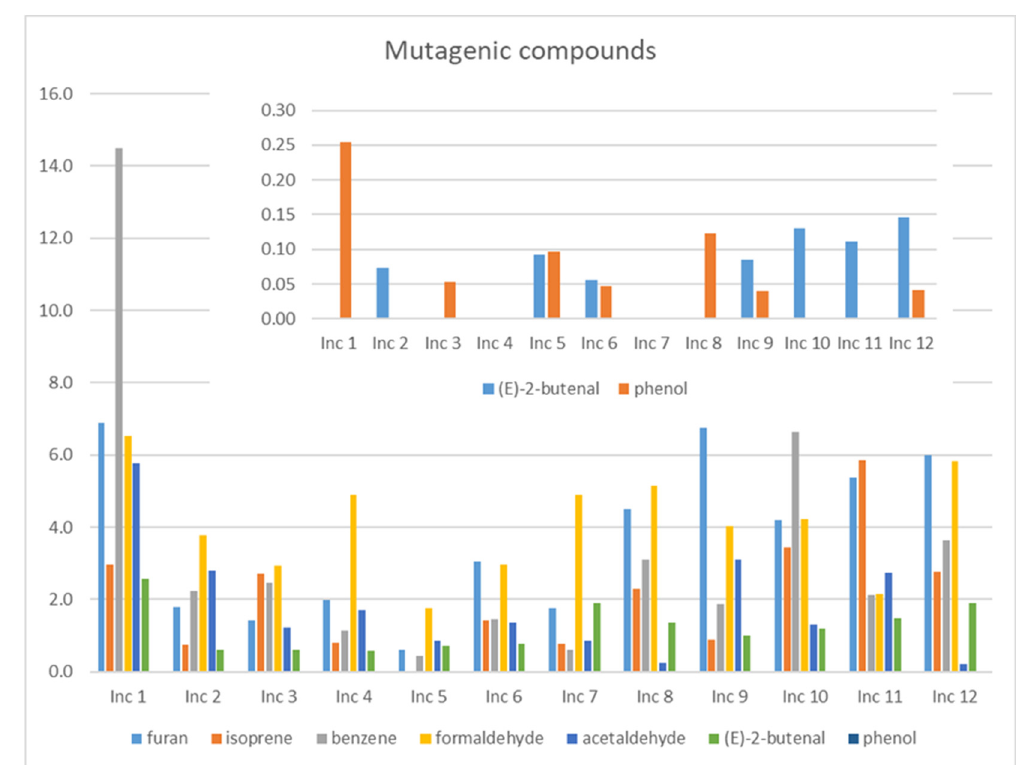
Figure 2. TWA levels ( μ g/m 3 ) of the mutagenic and suspected to be mutagenic compounds in the twelve products studied.